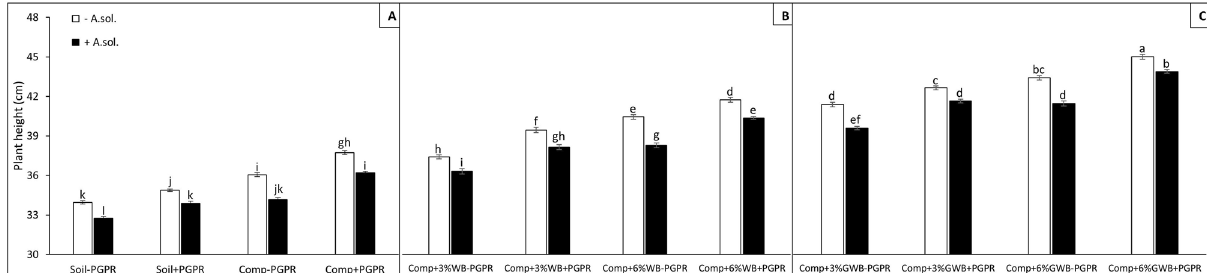
Figure 1. Effect of Alternaria solani and PGPR on tomato plant height grown in various soil substrate compositions including; ( A ) soil and compost (Comp) alone with (+ PGPR) and without PGPR (− PGPR), inoculated (+ A. solani ) or un-inoculated (− A. solani ), ( B ) compost (Comp) with 3 and 6% wood biochar (WB) with (+ PGPR) and without PGPR (− PGPR), inoculated (+ A. solani ) or un-inoculated (− A. solani ), ( C ) compost (Comp) with 3 and 6% Green waste biochar (GWB) with (+ PGPR) and without PGPR (− PGPR), inoculated (+ A. solani ) or un-inoculated (− A. solani ). All values represent mean ± SE, recorded 40 days after transplantation. Bars with different letters on the top suggest significant difference as per Tukey’s HSD test ( P ≤ 0.05).